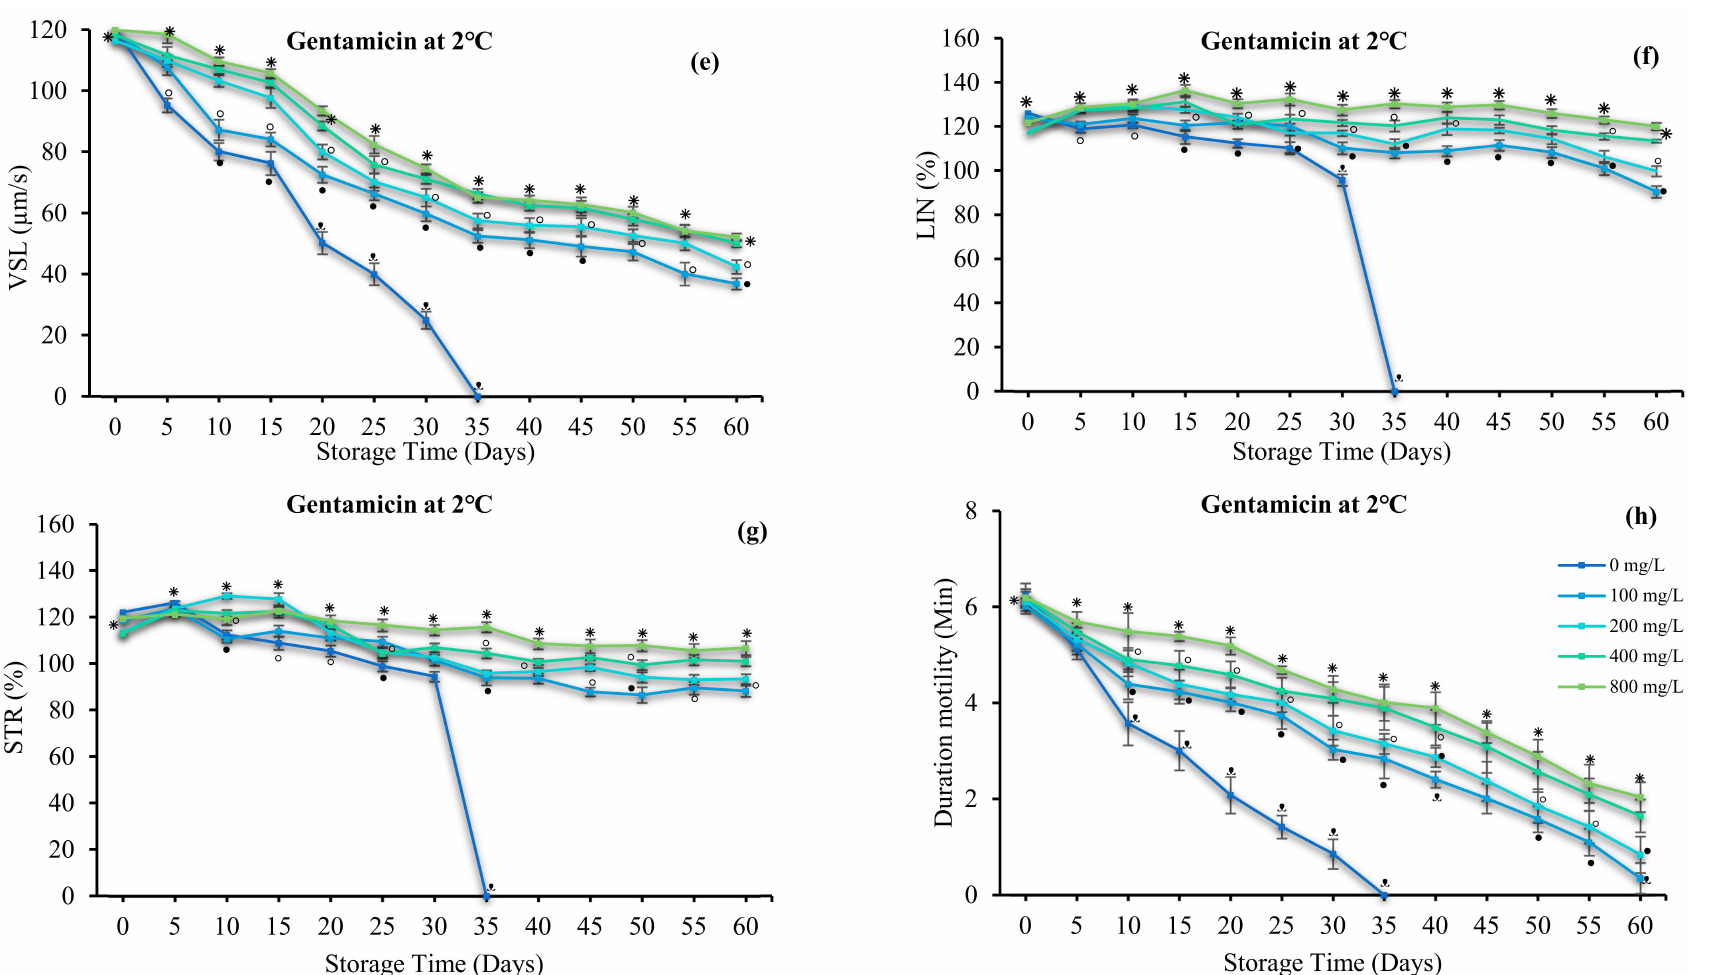
Figure 4. Effect of gentamicin (G) on the sperm of spotted halibut ( Verasper variegatus ) stored in Stein’s solution for 60 days at 2 °C. ( a ) Motility (%), ( b ) viability (%), ( c ) average path velocity (VAP; µm/s), ( d ) curvilinear line velocity (VCL; µm/s), ( e ) straight-line velocity (VSL; µm/s), ( f ) linearity (LIN; %), ( g ) straightness (STR; %), and ( h ) duration motility (minutes). Symbols ( ⁕ , ⸰ , • , ᵜ , ▪ ) indicate significant differences ( p < 0.05).